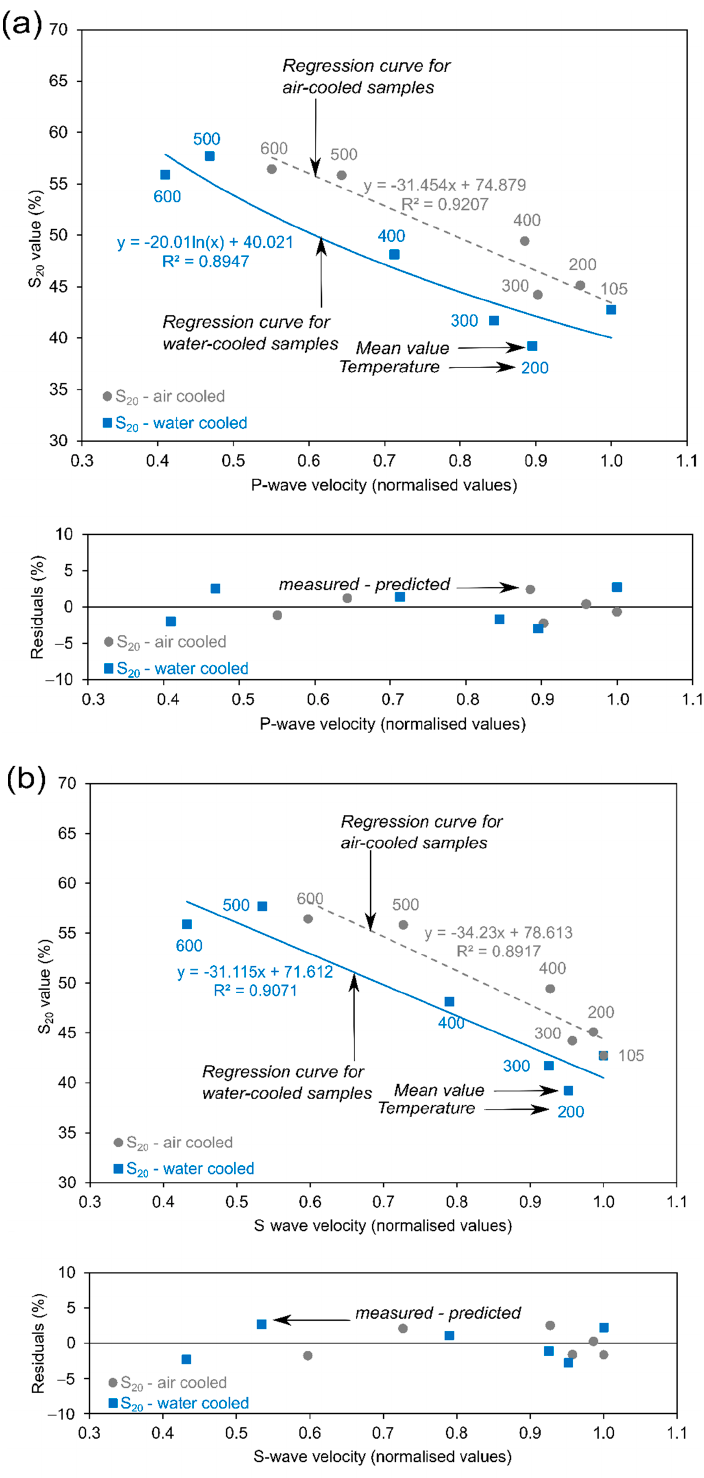
Figure 13. Correlations between variation of S 20 and P- ( a ) and S-wave velocity ( b ) for air- and water ‐ cooled samples.